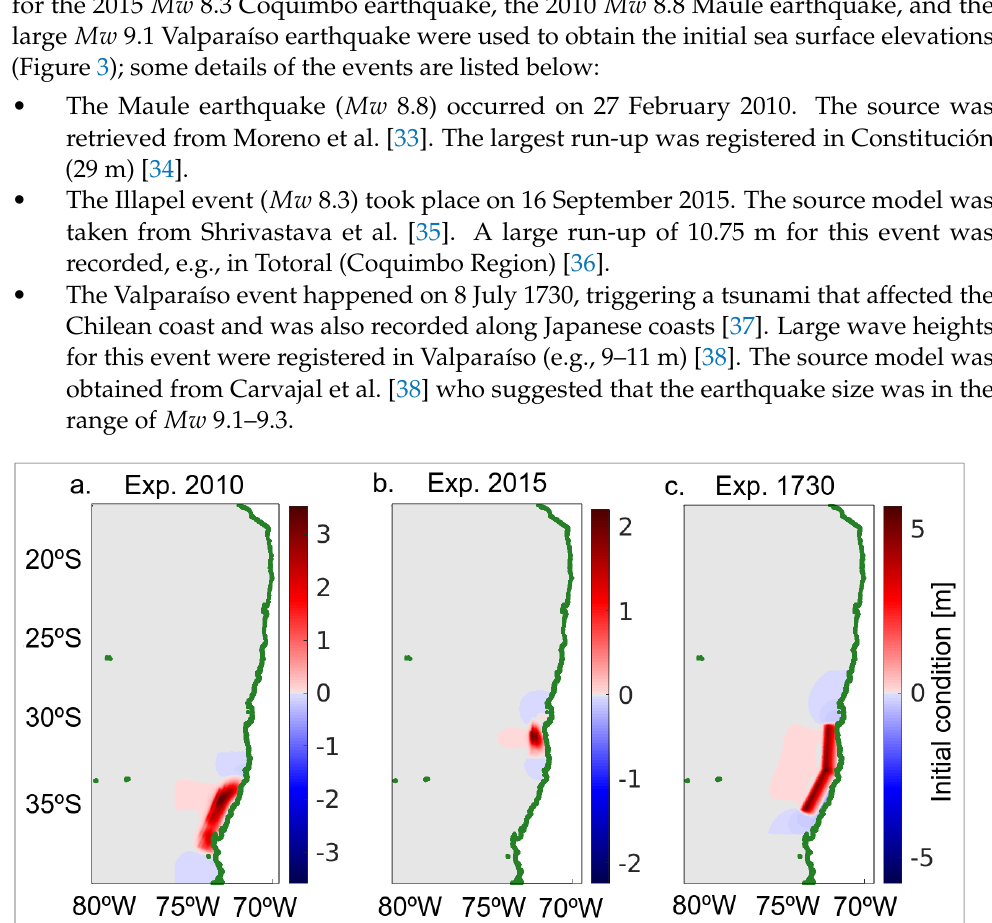
Figure 3. Initial sea surface elevation for the three experiments: ( a ). Experiment based on the 2010 Maule earthquake [33]. ( b ). Experiment based on the 2015 Illapel earthquake [35]. ( c ). Experiment based on the 1730 Valparaíso earthquake [38]. More information about slip distribution is shown in Figure S2 of the Supplementary